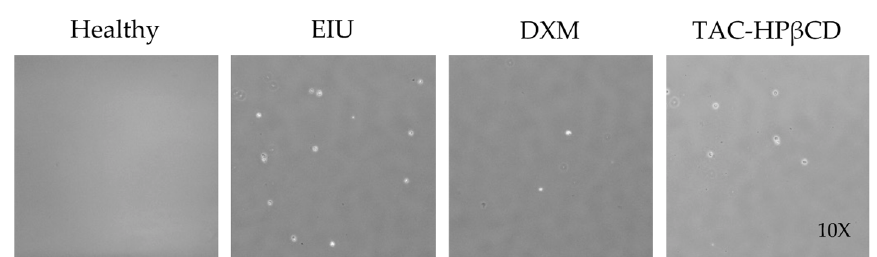
Figure 3. Leucocyte counting in aqueous humor 24 h after LPS injection in a Neubauer chamber. Groups were healthy eyes (Healthy), EIU untreated rats (EIU), EIU rats treated with dexamethasone (DXM) and EIU rats treated with TAC-HP β CD (TAC-HP β CD) ( n = 3 eyes).